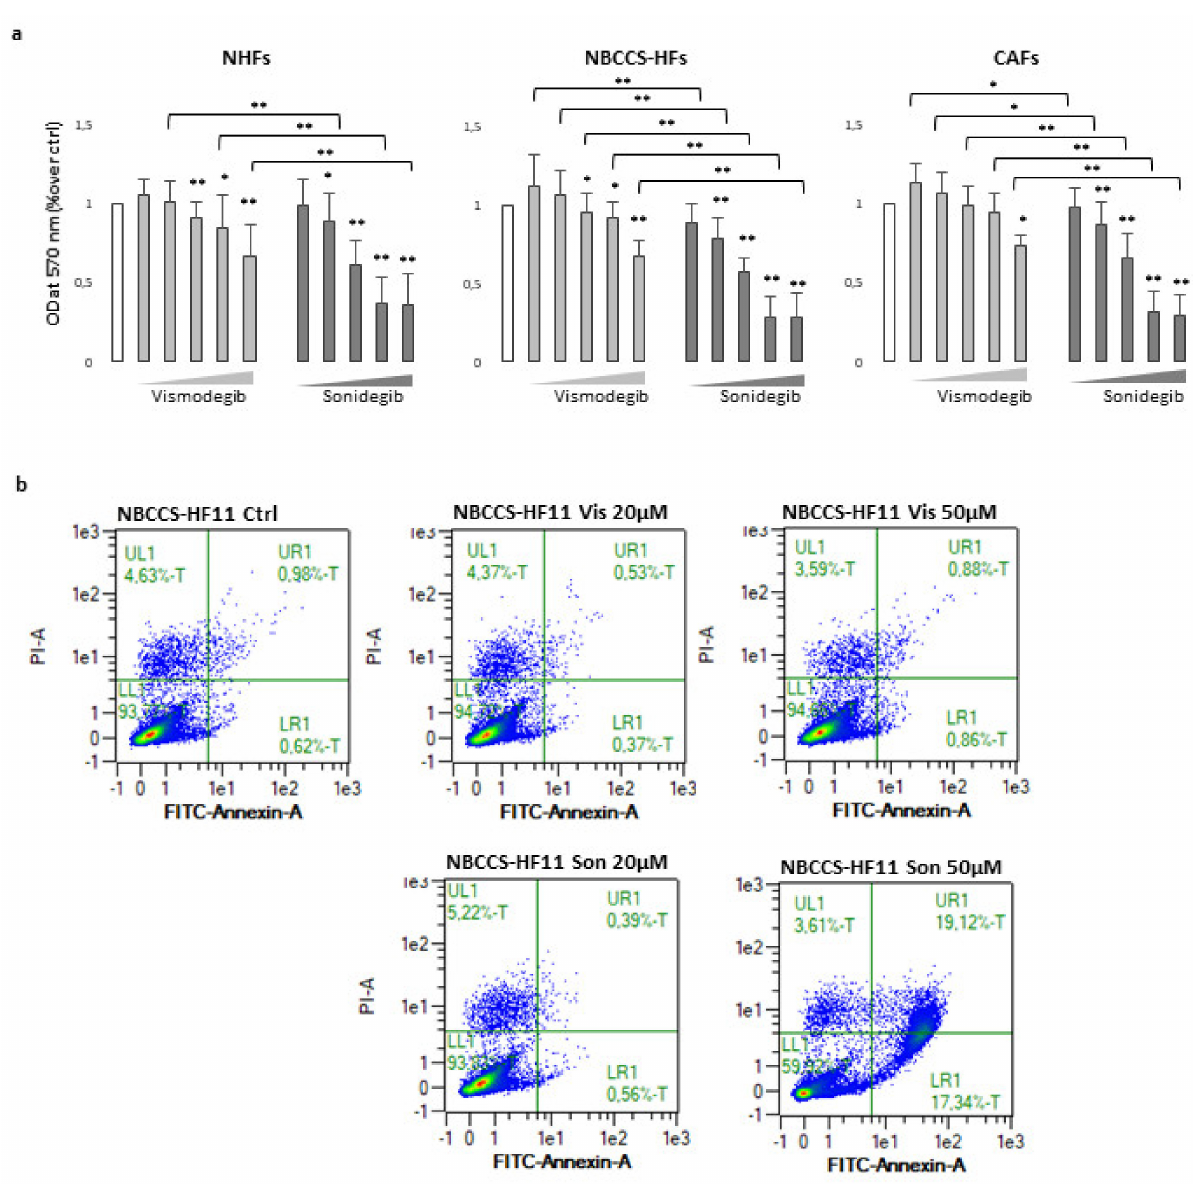
Figure 1. ( a ) MTT assay of NHFs (n = 11), NBCCS-HFs (n = 9) and CAFs (n = 6) after 72 h treatment with vismodegib and sonidegib (range 5–100 µ M). Data are reported as mean ± SD. Experiments were performed in duplicate. ( b ) An- nexinV/iodide propidium staining evidenced apoptosis cell death only with sonidegib treatment. Dot plots show one representative experiment performed 48 h after Hh inhibitors treatment. * p ≤ 0.05 and ** p ≤